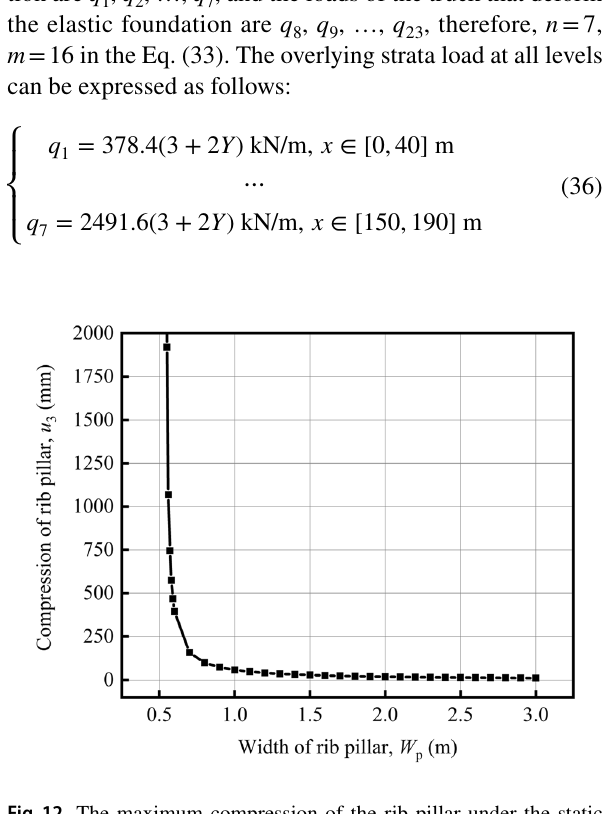
Fig. 11 Compression of the rib pillar under the dynamic load of truck at full load under the No. 1 haulage bench